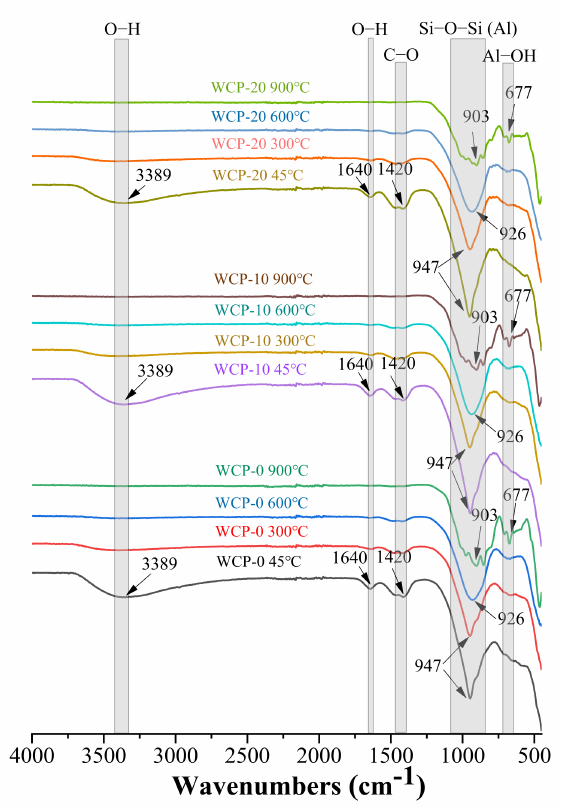
Figure 8. FTIR spectra of all samples before and after